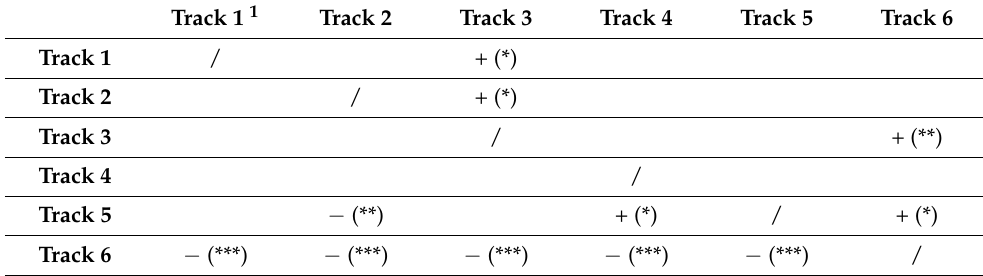
Table 7. The comparison of track numbers’ influence on paddle frequency between Q1 and Q2.